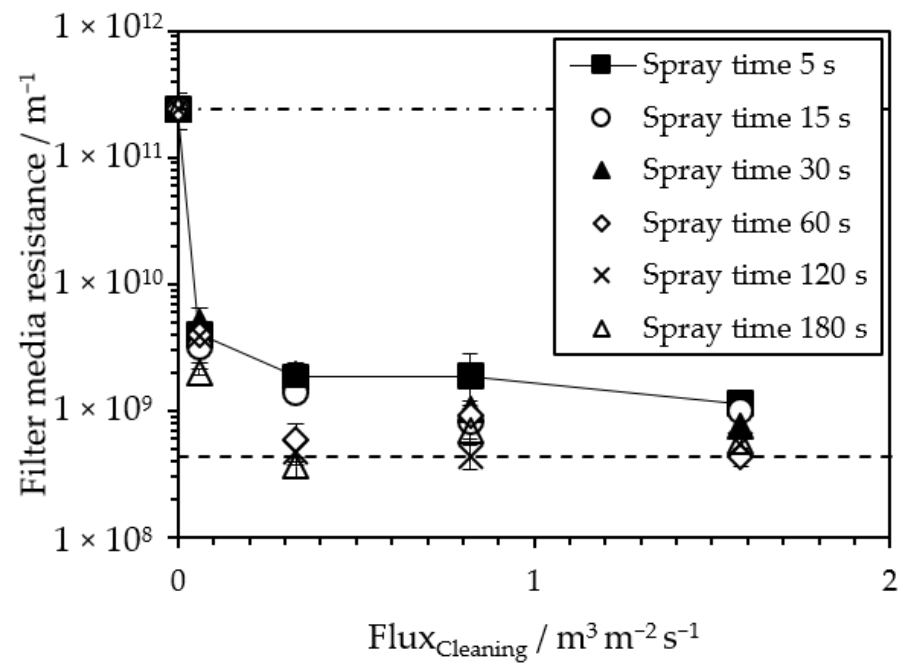
Figure 4. Filter media flow resistance after front-wash cleaning for the different spray times over flux. Blinded (after 1000 filtration cycles) and unused state are depicted as a reference with a dot-dashed and a dashed line.